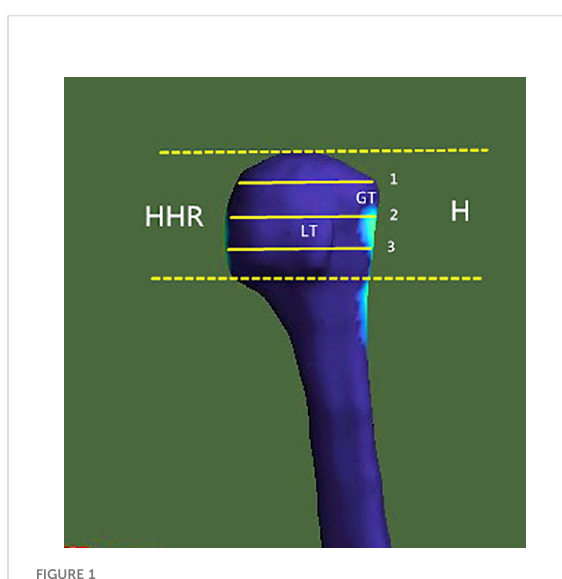
FIGURE 3 Placement of the regions of interest (ROIs) Nine ROIs were de fi ned in the humeral head region. (A) Anterior view; (B) posterior view. GT, greater tuberosity; LT, lesser